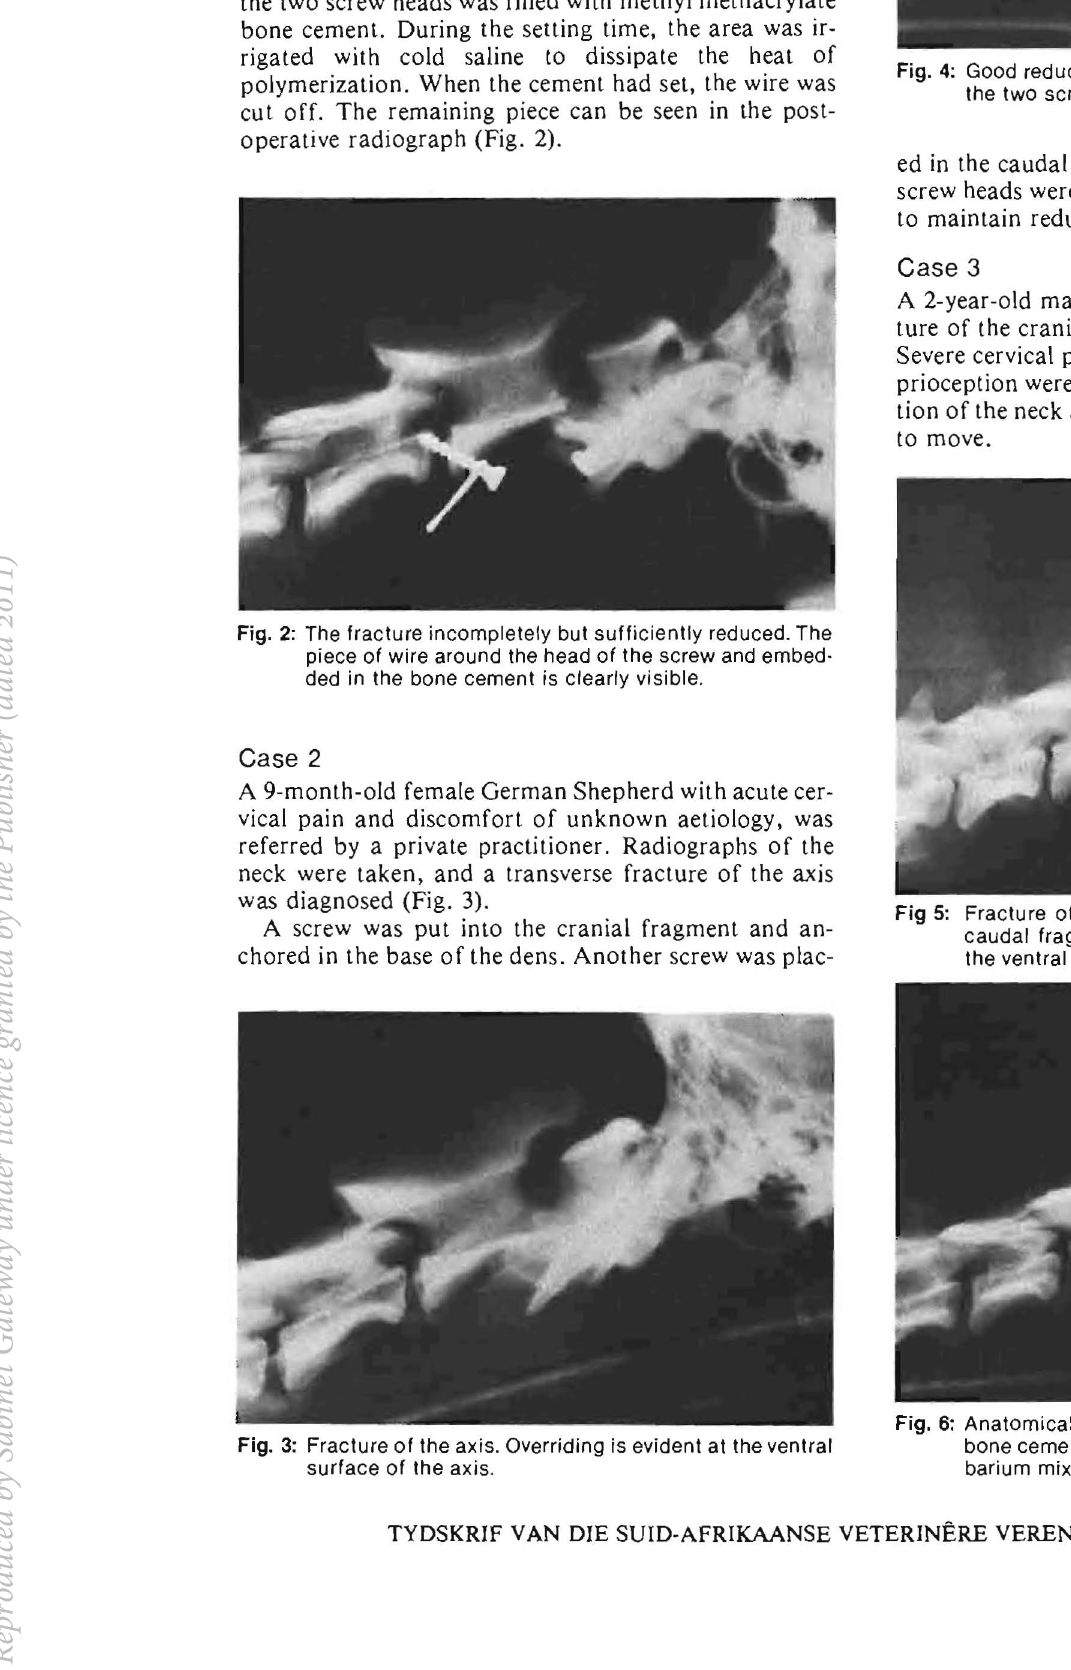
Fig. 3: Fracture of the axis. Overriding is evident at the ventral surface of the axis.